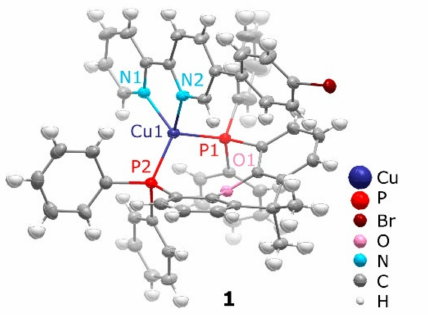
Figure 1. ORTEP view of cation 1 , ellipsoids are shown at 30% probability. Complexes 1 , 2 , on the one hand, and 6, on the other hand, demonstrate different orientations of the asymmetrical NˆN ligand with respect to the Xantphos backbone. The substituted − C 6 H 4 X ring in the 5-position of the bipyridine ligand in 1 and 2 is located